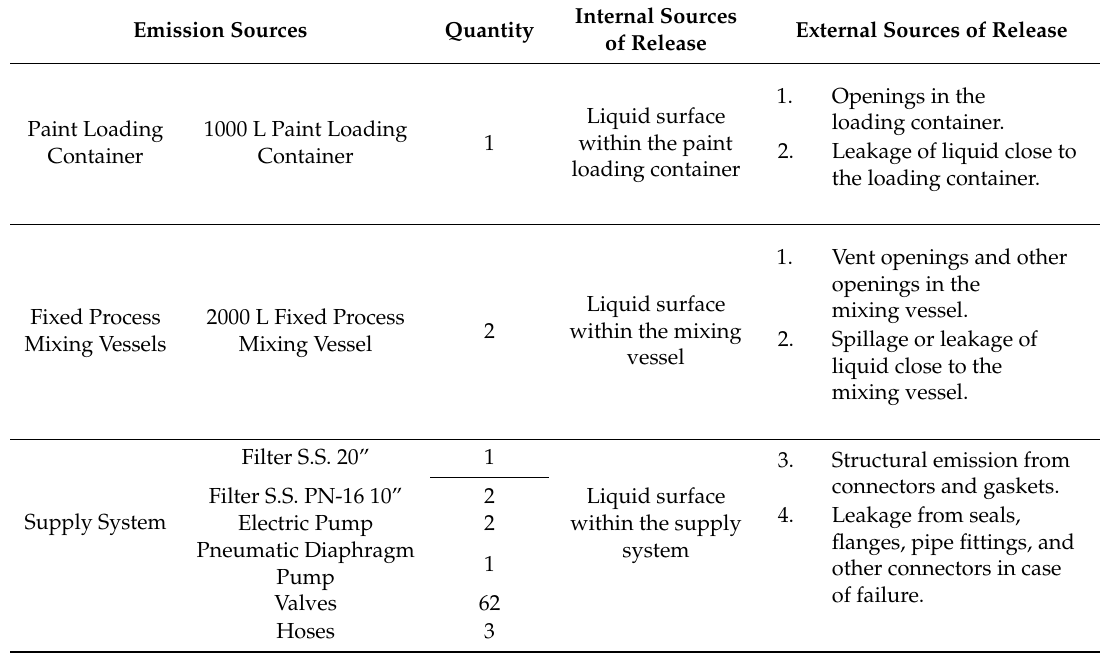
Table 12. Emission sources identification for the basic paint mixing unit.